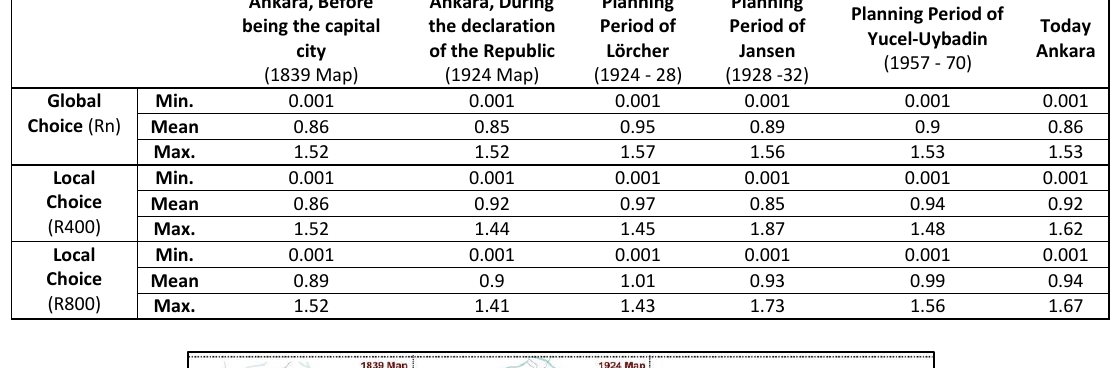
Table 3 Global and local choice values of the historical periods.